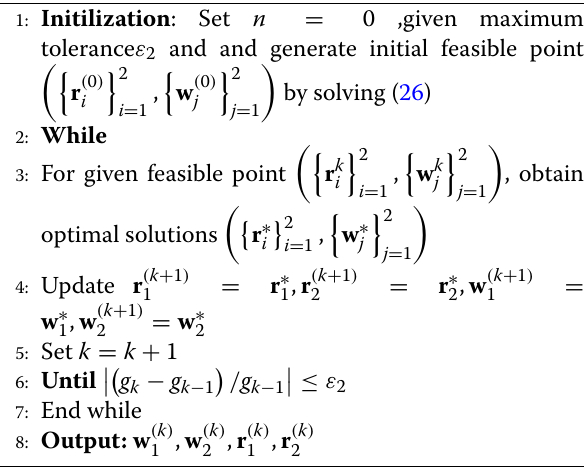
ear constraints. The convergence and generation of initial